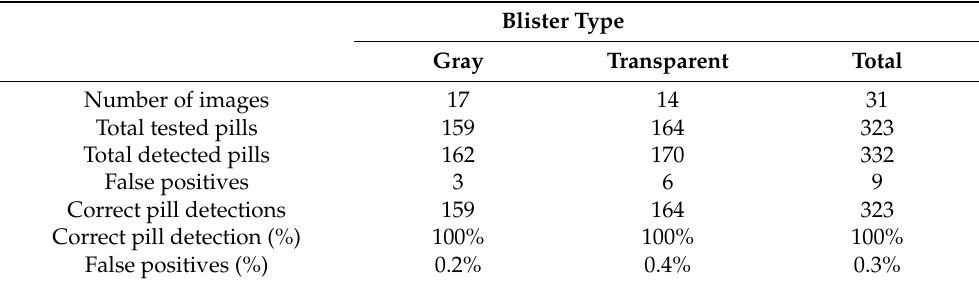
Table 2. Results of Test 2 (Registration mode).